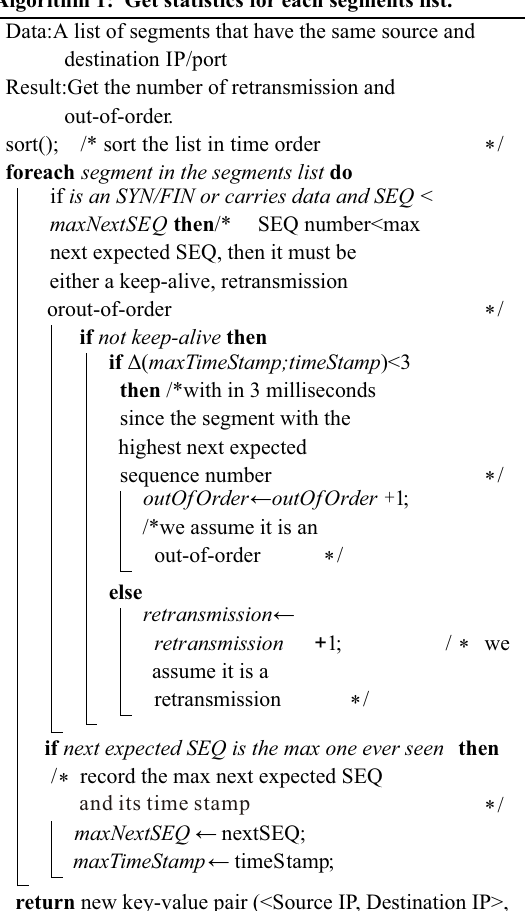
Algorithm 1: Get statistics for each segments list.